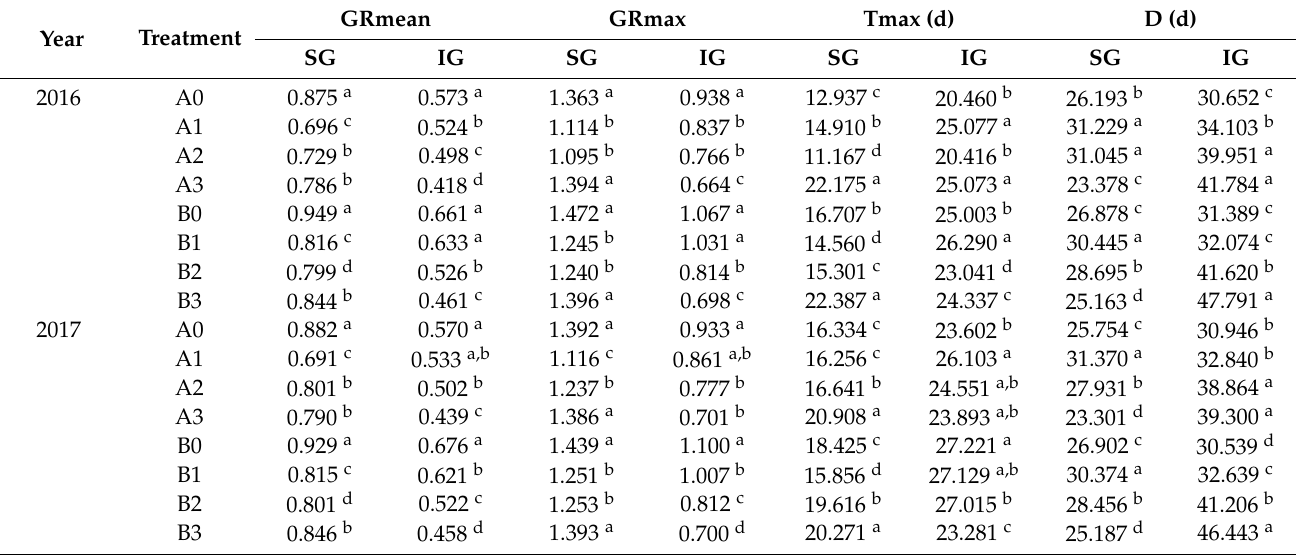
Table 2. Effects of drought stress at the jointing–booting stage on grain-filling characteristics of superior and inferior grains in growth period overlapping rice in 2016 and